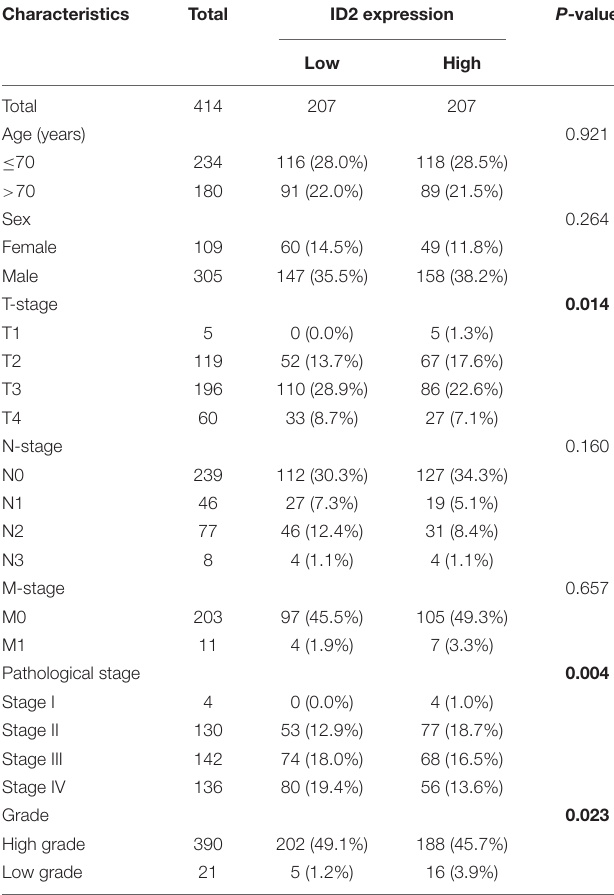
TABLE 1 | The relationship between the expression of ID2 and various clinicopathological variables in the TCGA database.